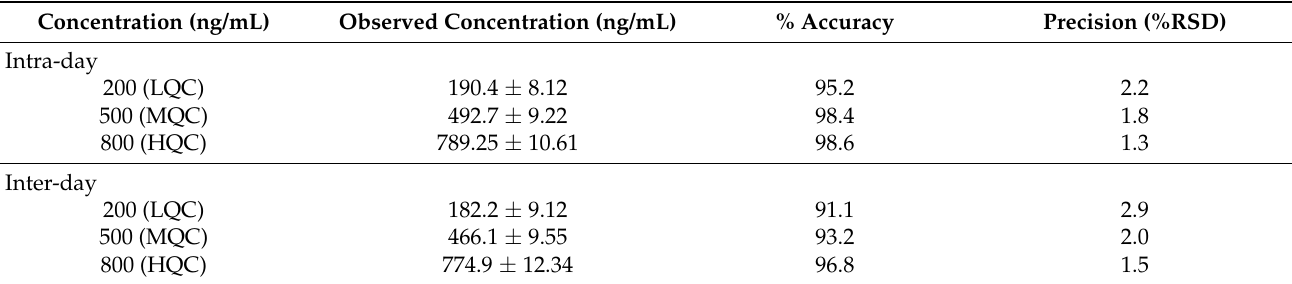
Table 7. Intra-day accuracy and precision of ACV in rat plasma samples.